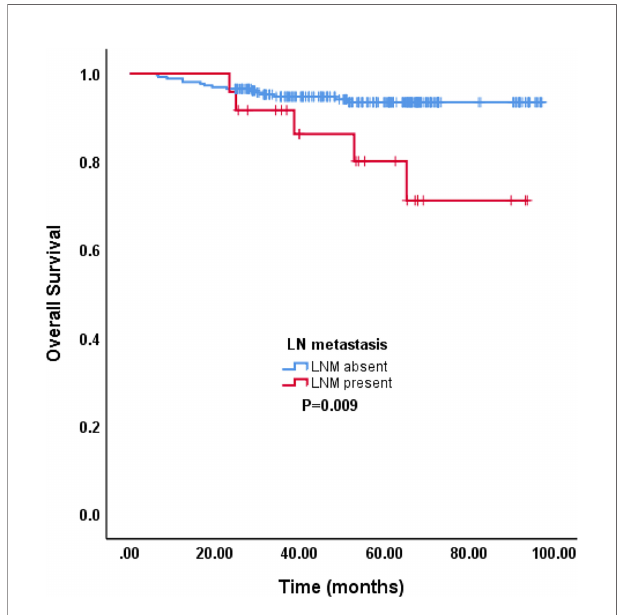
FIGURE 1 | The survival between LNM absent and LNM present.